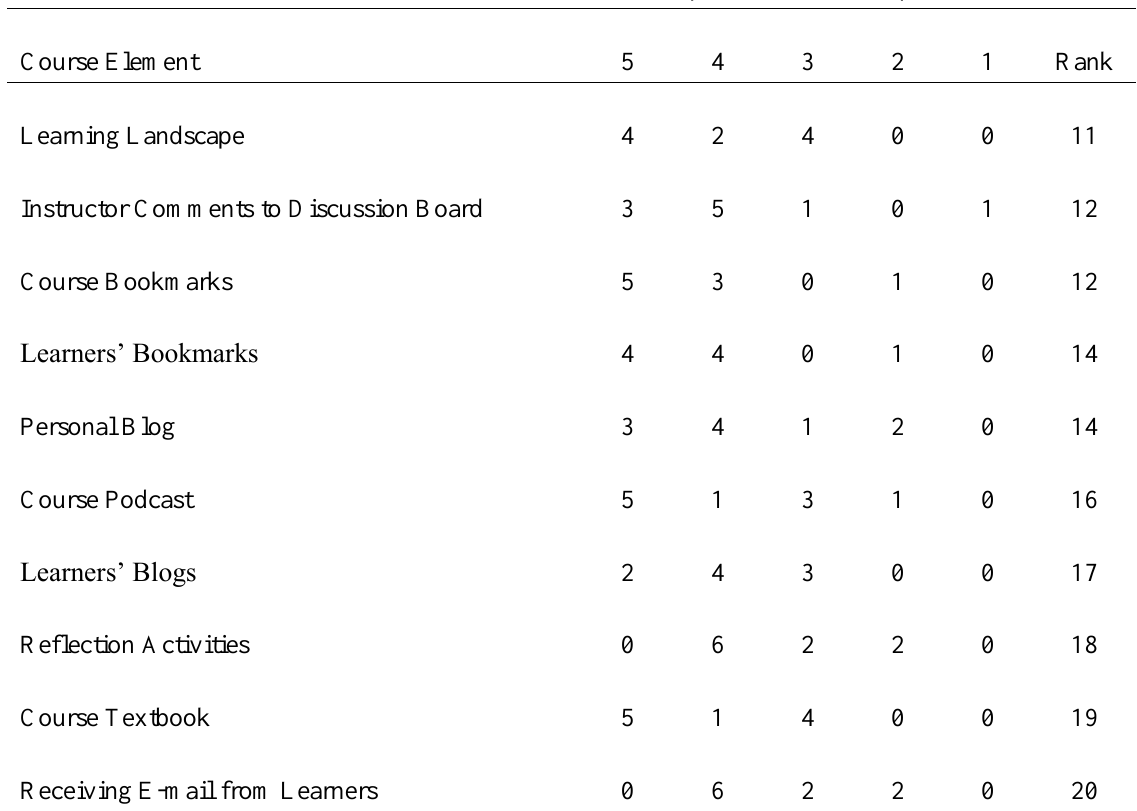
Response Frequencies Most